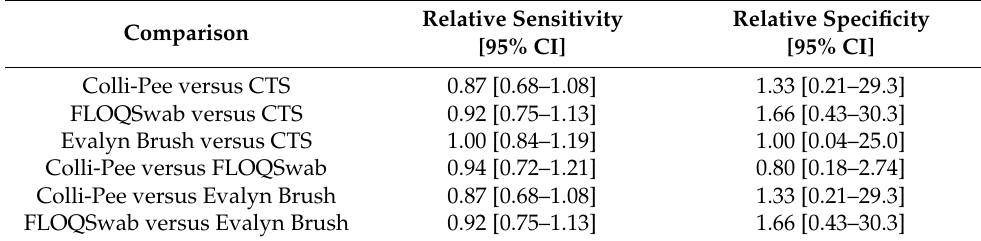
Table 3. Relative sensitivity and specificity for CIN 2+ ( n = 65).